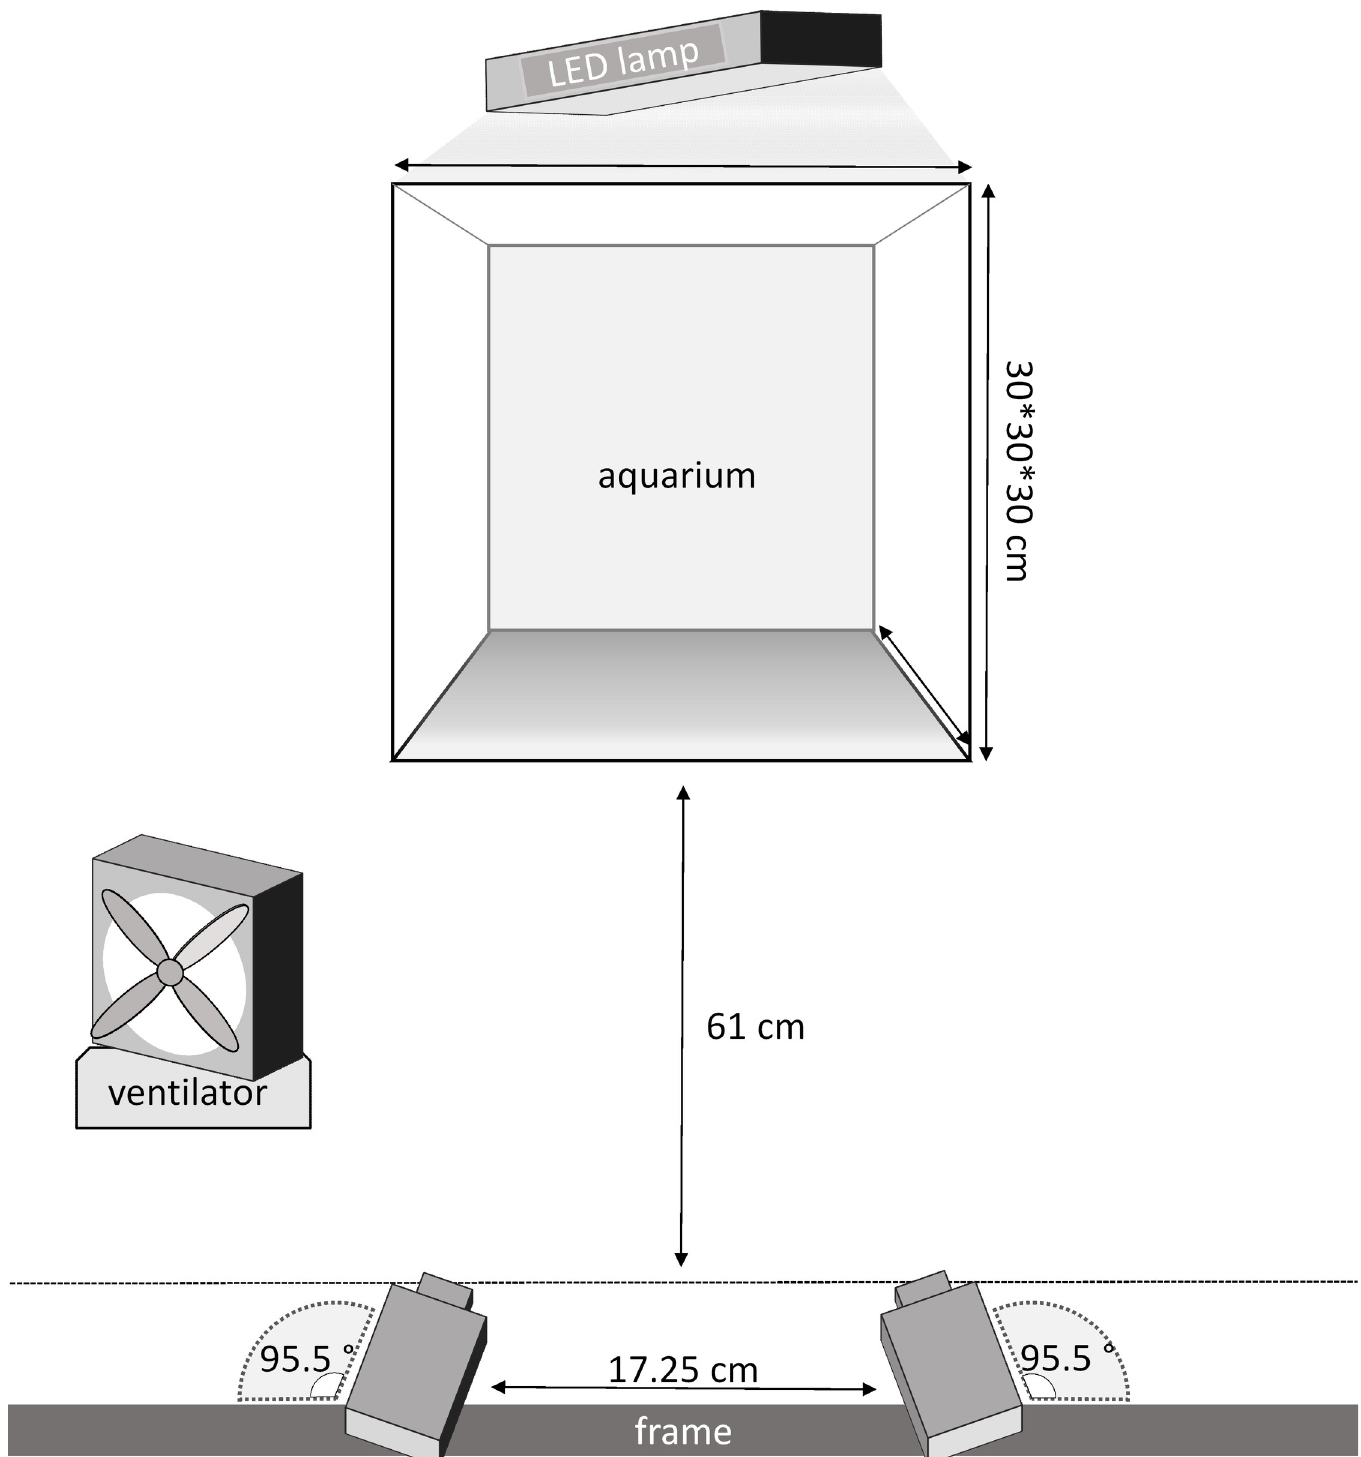
Fig 1. Experimental tank setup. Experimental tank setup consisting of a tank with dimensions of 30 x 30 x 30 cm, two high-speed cameras in a fixed stereo rig, LED lights for illumination and a ventilator to prevent condensation on the glass.